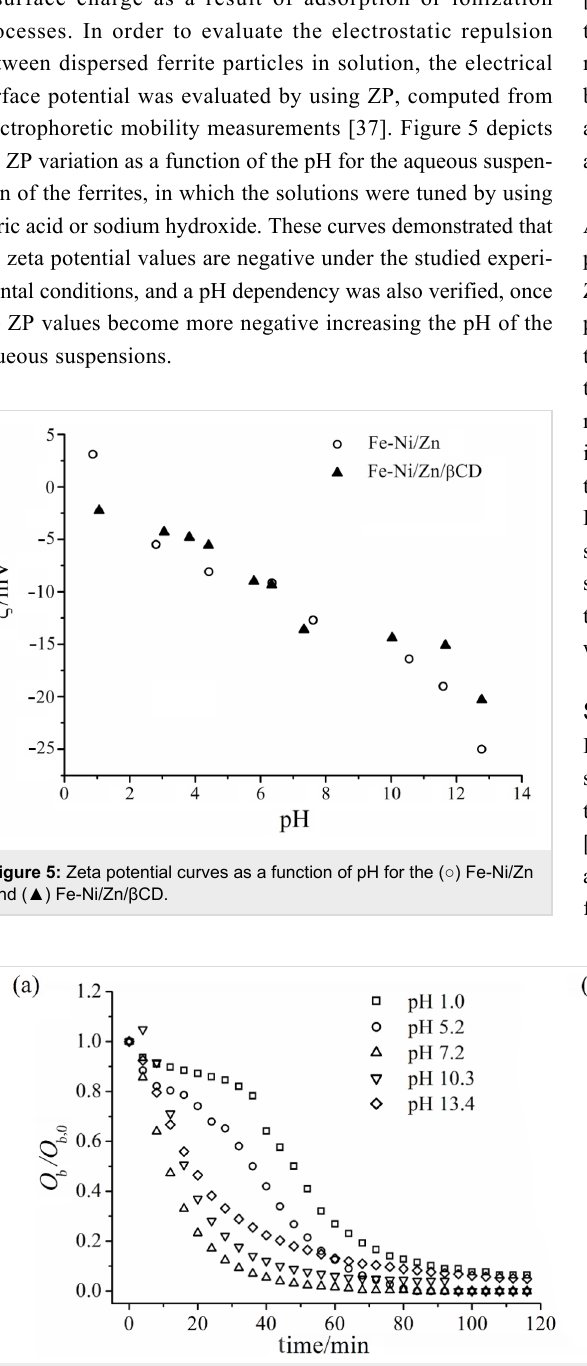
groups. These results emphasize that β CD is part of the inor-